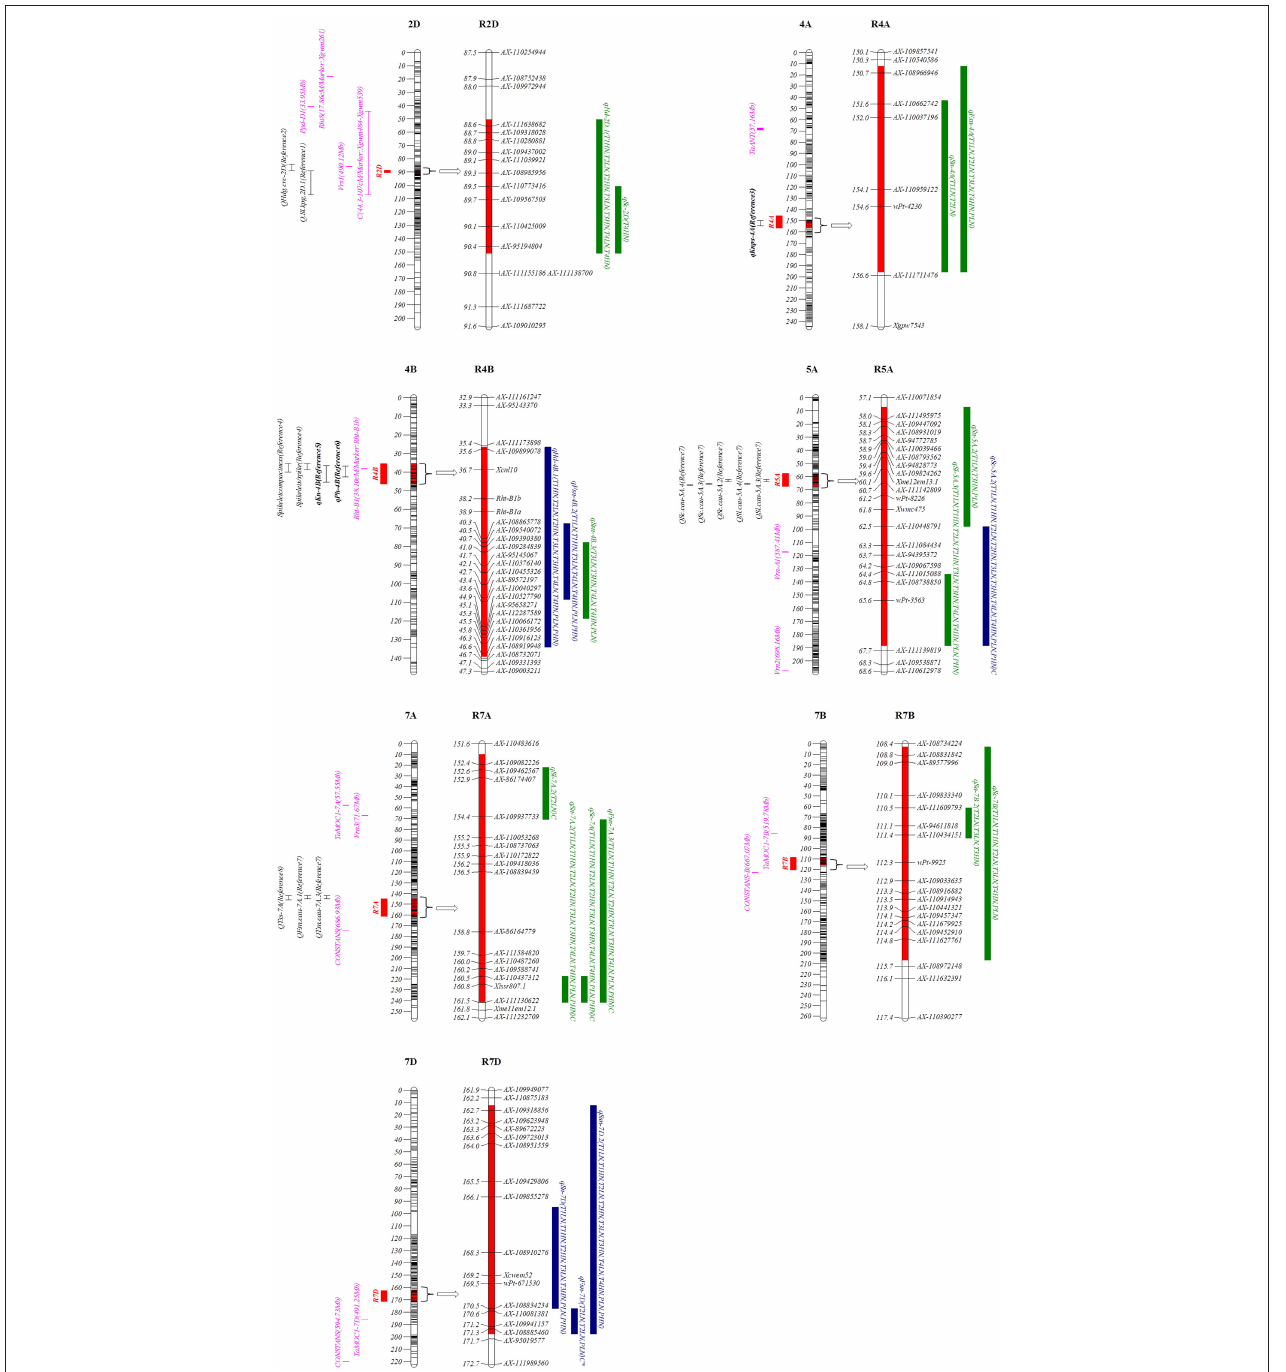
FIGURE 1 | Chromosomal locations of seven highlighted genomic regions for spike characteristics in this study. The red intervals on the chromosomes and regions represent the LOD-3 confidence interval of the location of each genomic region. To the left of the chromosomes: the centiMorgan (cm) interval is shown; the red rectangles represent each QTL region; the purple lines represent the putative location of the screened genes associated with spike-related traits; the black intervals represent the coincident QTL in previous reports (Reference 1 to Reference 11), and among them, three QTL in bold ( qKnps-4A , qPh-4B, and qKn-4B ) were detected using the same population of this study (KJ-RILs). On the right of each chromosomal region: the blue and green rectangles represent the QTL with positive alleles from KN9204 and J411, respectively; the letter C after parentheses represents the expression of QTL induced by N deficiency, and among them, C * represents the QTL ( qFsn-7D ) is a completely LN-stress induced QTL. Reference 1: (Nishijima et al., 2017); Reference 2: (Cuthbert et al., 2008); Reference 3: (Cui et al., 2017); Reference 4: (Heidari et al., 2011); Reference 5: (Zhang et al., 2017); Reference 6: (Fan et al., 2015); Reference 7: (Zhai et al., 2016); Reference 8: (Xu et al., 2014).